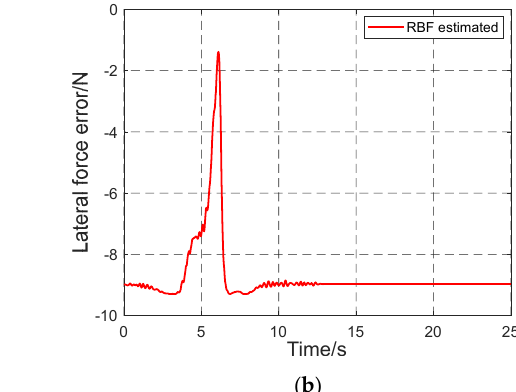
Figure 10. Estimation results based on RBF neural network tire lateral force under ice-covered pavement; ( a ) The lateral force; ( b ) Discrepancy between the estimated lateral force and the true value.